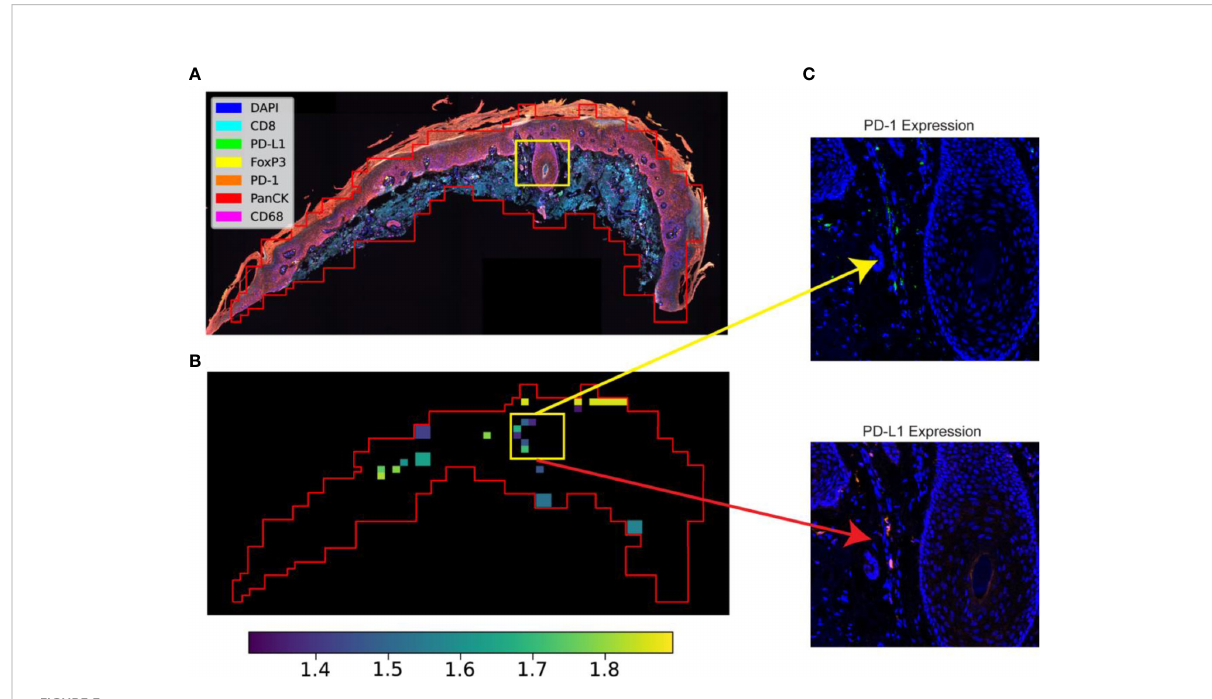
FIGURE 3 STRISH application to protein data. (A) A multispectral image captured using MOTiF ™ PD-1/PD-L1 panel (6 proteins and a DAPI) of an SCC cancer tissue section. (B) STRISH signi fi cant test heatmap (activity map) suggesting the tissue locations with high (yellow color) or low (dark color) level of protein local co-expression after the statistical test for the ligand-receptor pair PD-1 and PD-L1 (the value shows in color bar indicate negative log p-values). The tissue contour was plotted using the windows of neighboring cells identi fi ed by STRISH. (C) A close-up visualization of the areas identi fi ed as the existing cells local co-expression of PD-1 and PD-L1 by